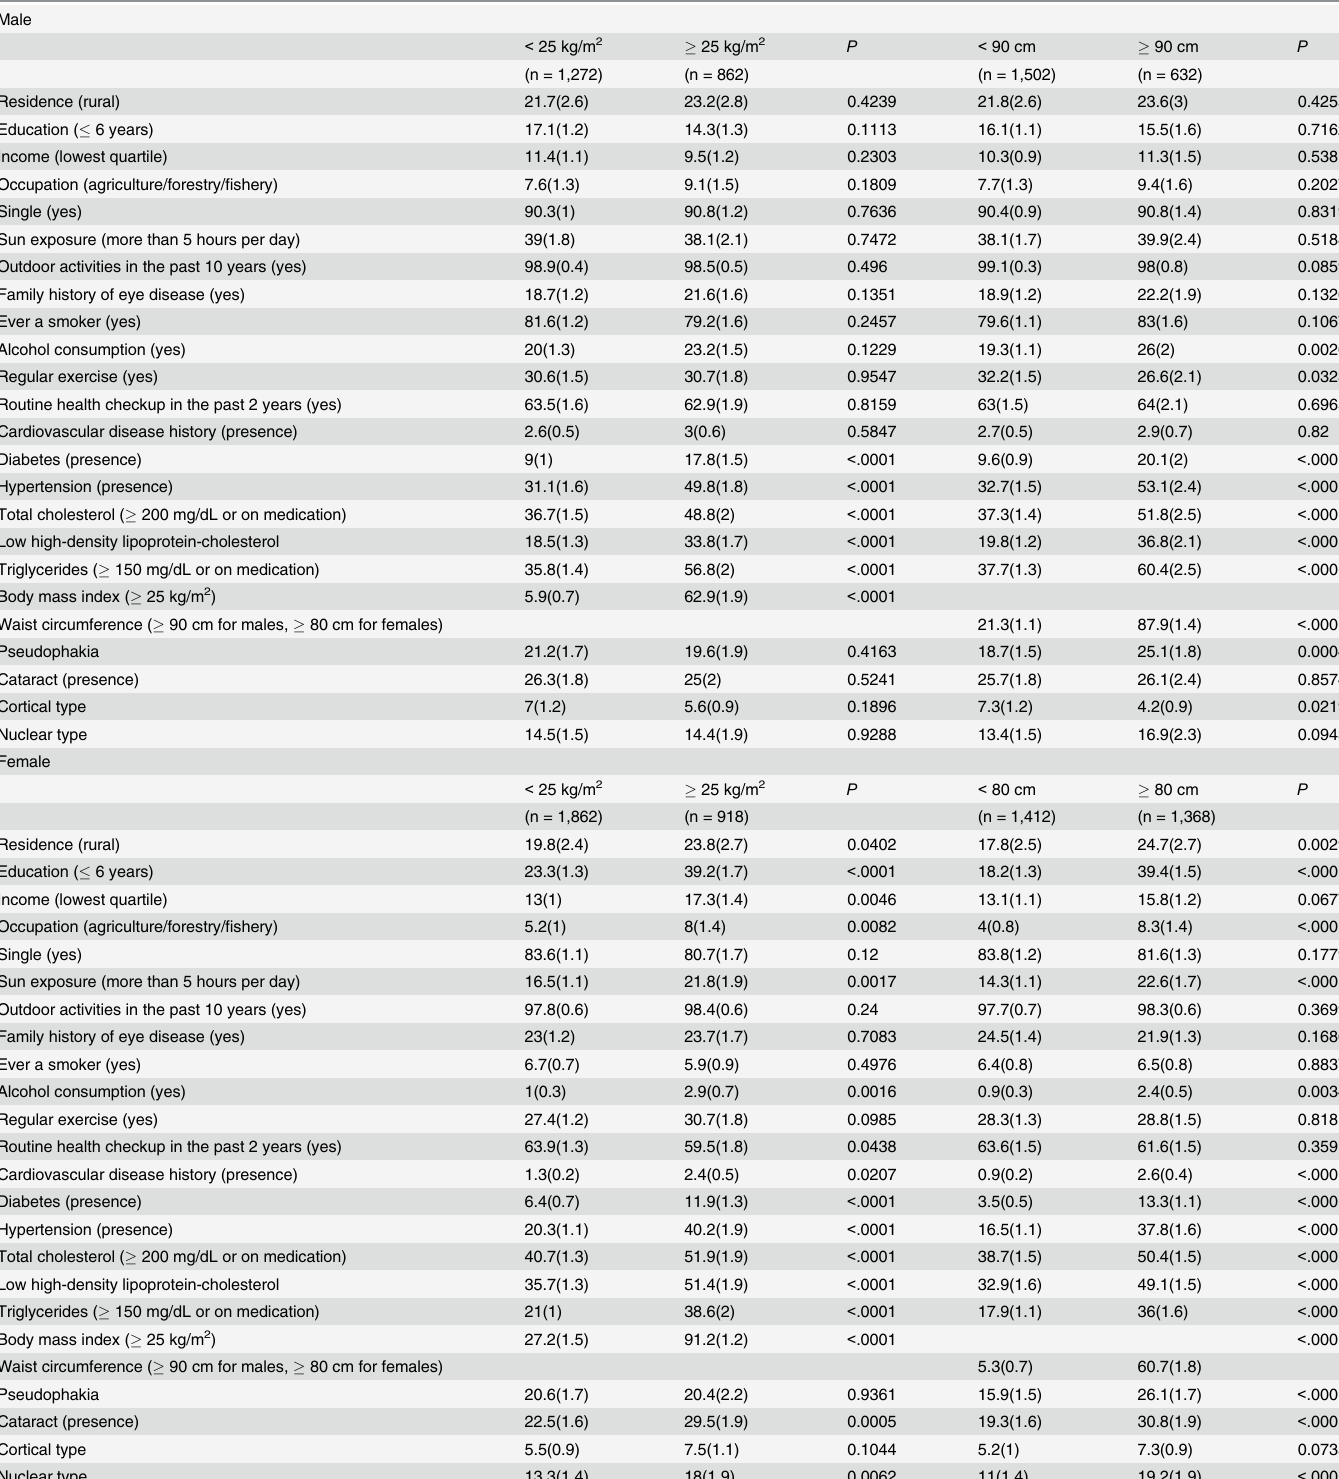
Table 1. General and clinical characteristics of the study participants according to